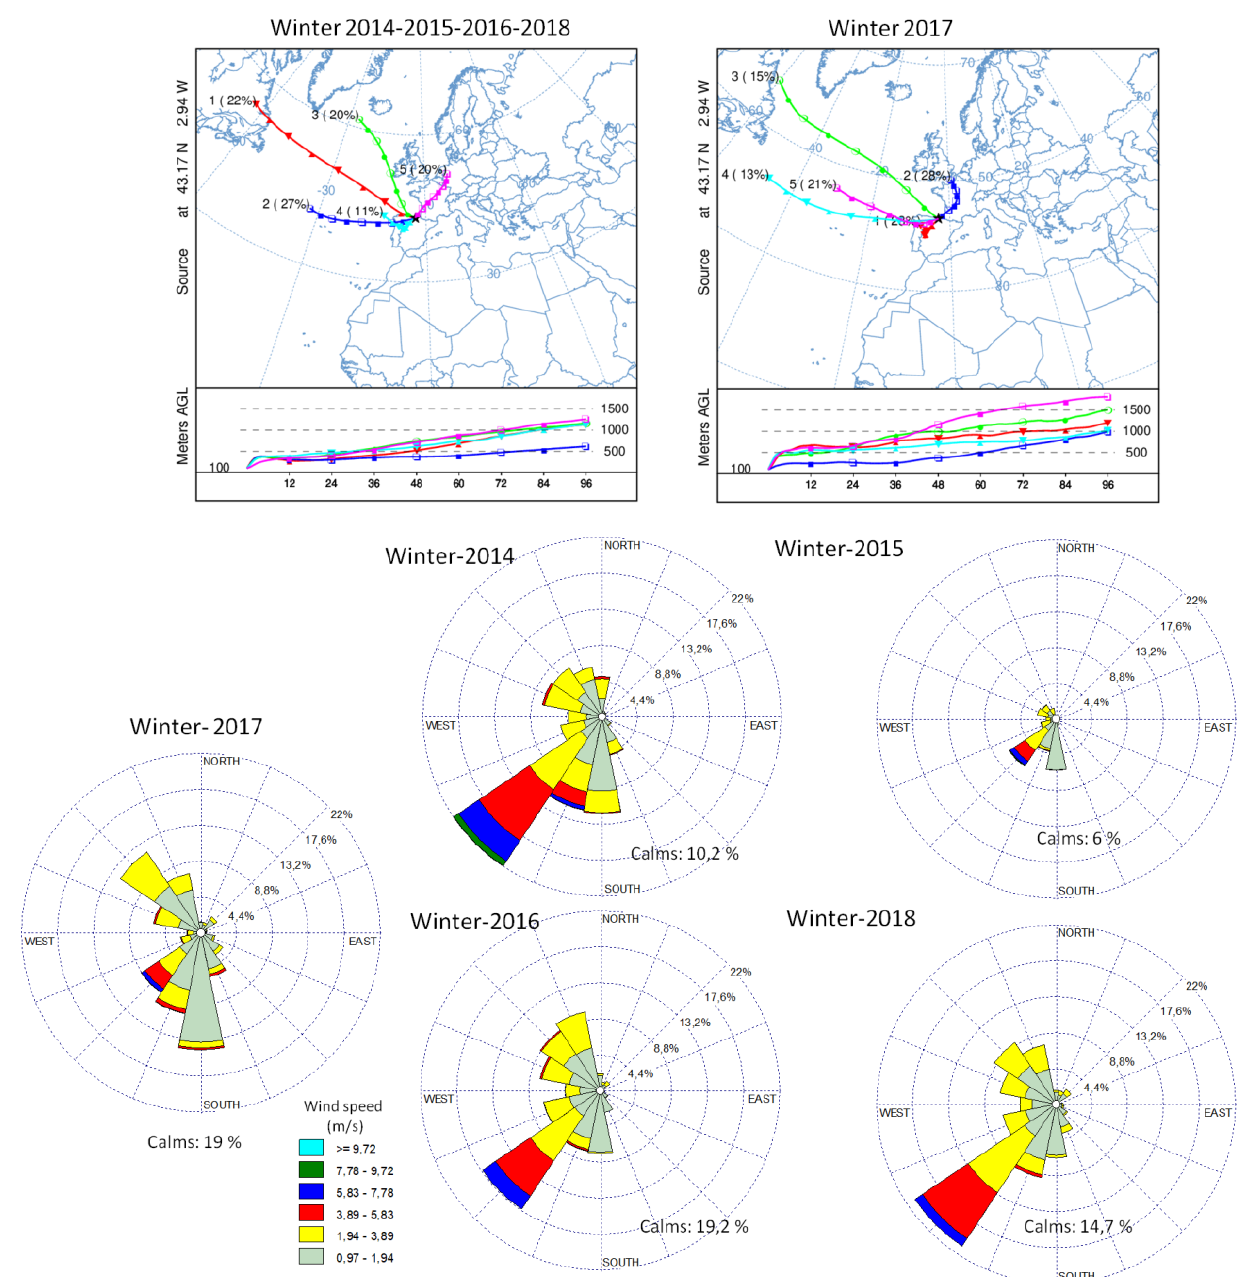
Figure 11. Back-trajectory cluster centers (centroids) obtained at 100 m agl obtained for airflow pattern for each period and wind roses showing the distribution of surface winds (direction and speed) in percentages for each period considered in Bilbao. The left numbers in the centroids are an identification number for the centroids, and the right numbers (in brackets) are the percentages of complete trajectories occurring in that